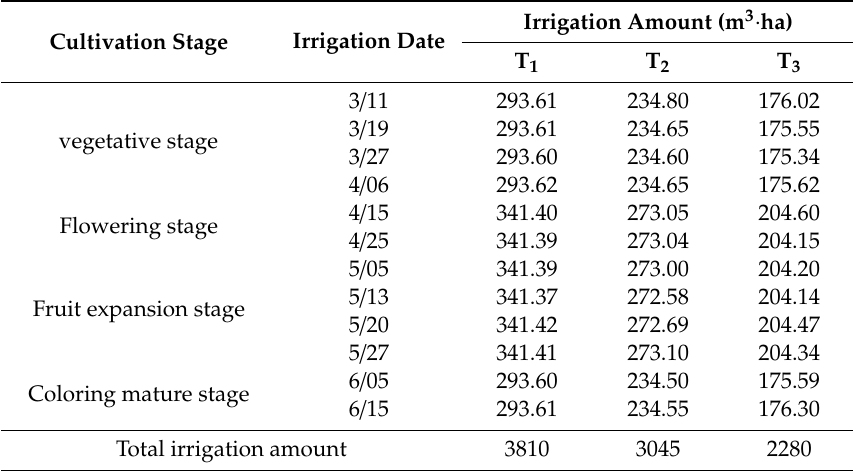
Table 3. Irrigation amount of grapevine under di ff erent cultivation